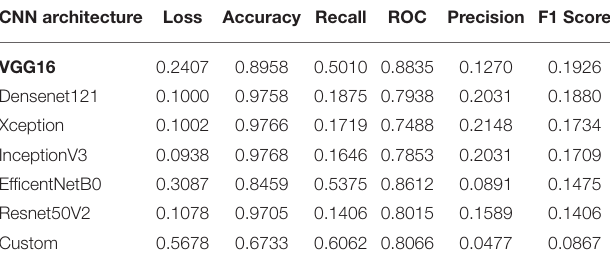
TABLE 1 | Performance metrics values of convolutional neural network (CNN) with one